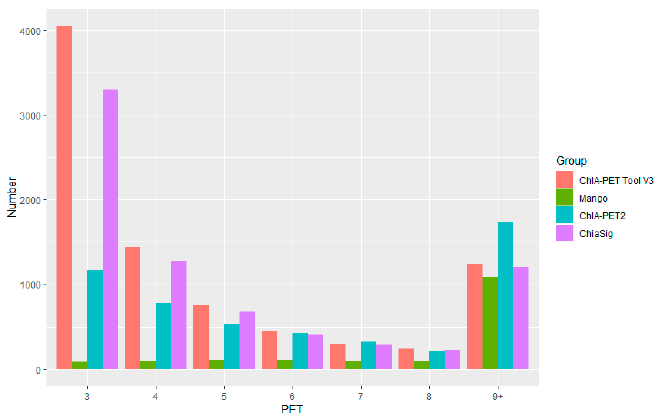
Figure A4. Paired-End Tag count distribution of significant interactions detected by different tools from human K562 cells.